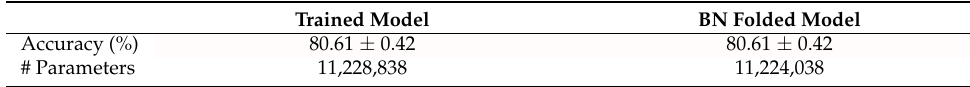
Table 8. Results of performing batch normalization folding on ResNet-18. Mean and standard deviation of accuracy over 3 rounds are reported. The darker the shade of red, the further the accuracy is from the baseline.